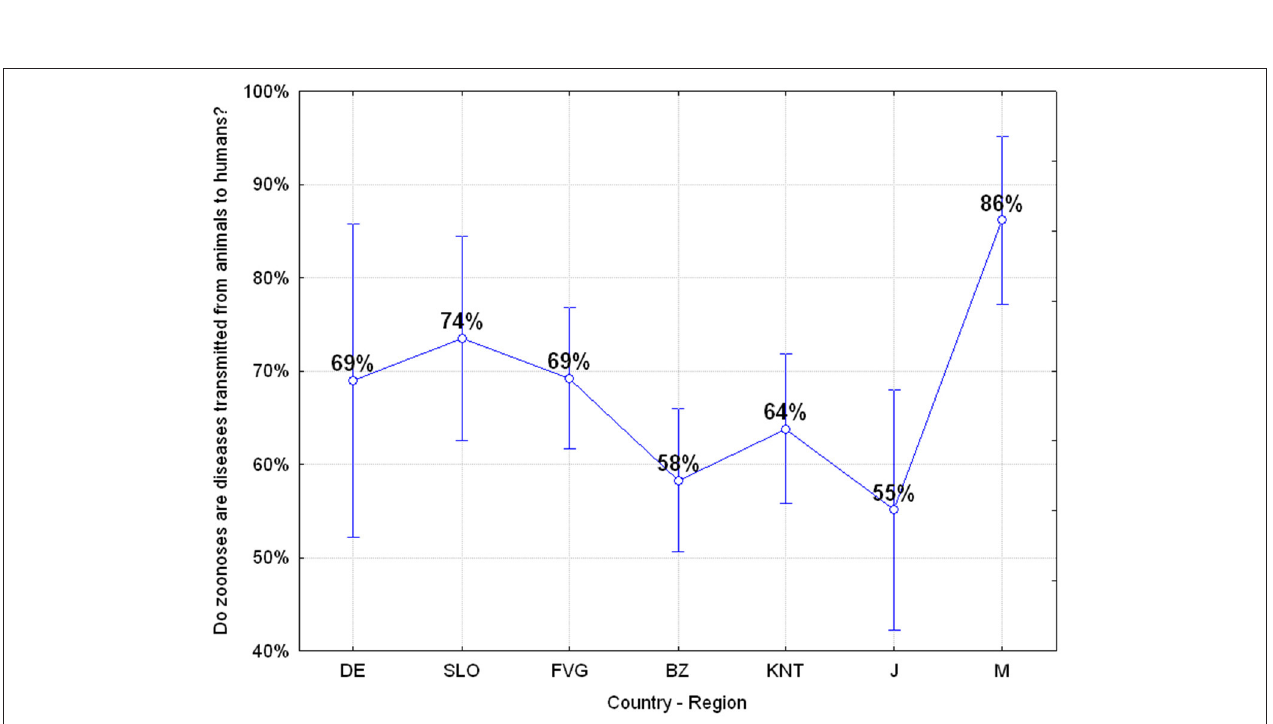
FIGURE 9 | Q23: “Zoonoses are diseases transmitted from animals to humans?” ANOVA F (6,649) p = 0.00012 [Axes X regions or countries, Axes Y % correct answers–DE, Germany; SLO, Slovenia; FVG, Friuli Venezia Giulia Italy; BZ, Autonomous Province of Bolzano Italy; KNT, Carinthia Austria; J, Japan; M, Mauritius–( n =